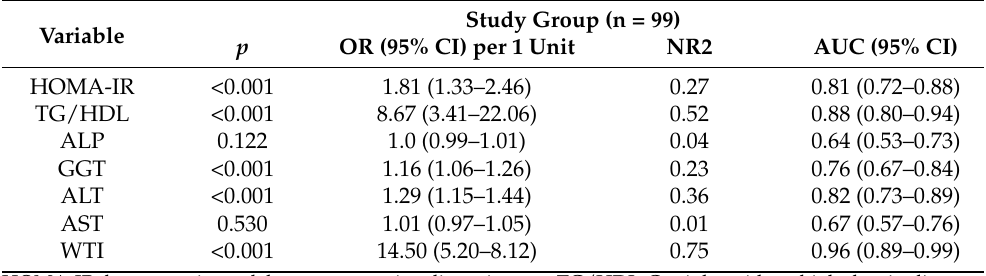
Table 2. Univariable logistic regression analysis for the prediction of MetS in the study group. Study Group (n = 99) Variable p